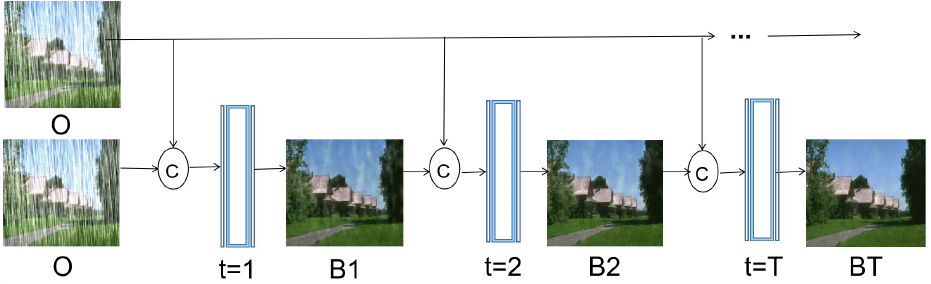
Figure 9. Illustration of PReNet [25]. Input O is the rain image, output BT is the clean background image of the T stage